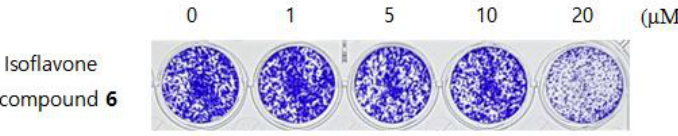
Figure 12. Effect of isoflavone 6 on the inhibition of clonogenicity of HCT116 colon cancer cells.